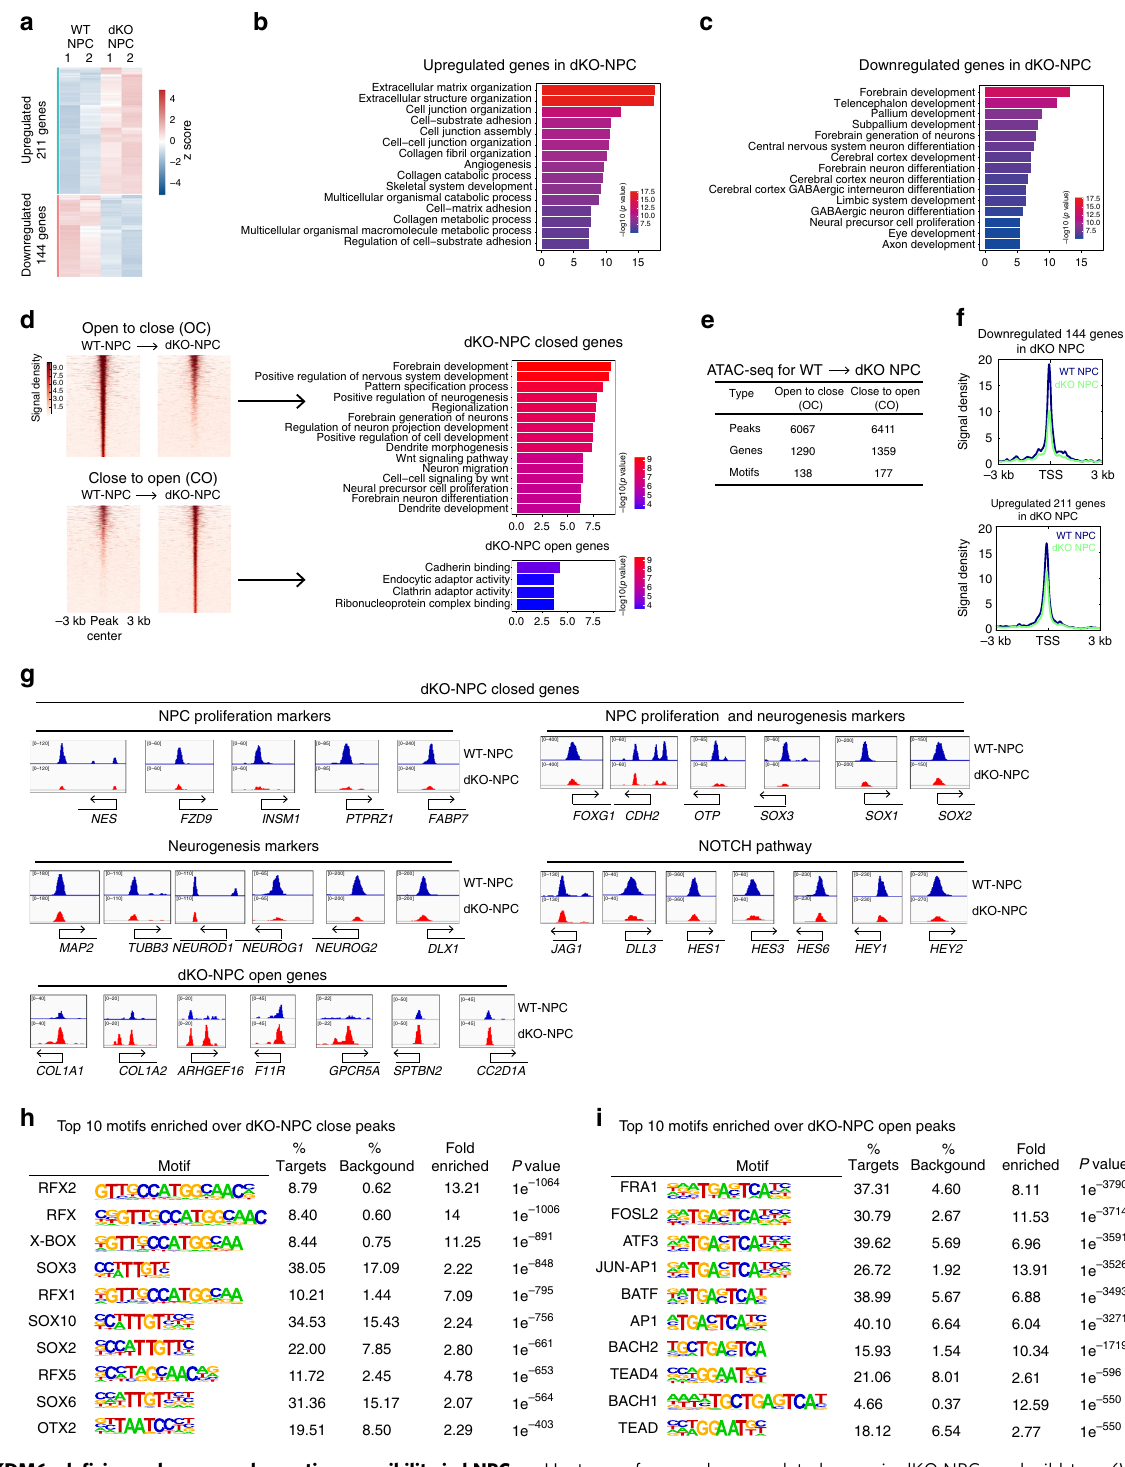
Fig. 4 KDM6s de fi ciency decreases chromatin accessibility in hNPCs. a Heatmap of up- or downregulated genes in dKO NPCs and wild-type (WT) NPCs at passage 2. b , c Top 15 GO terms most enriched in genes upregulated or downregulated in dKO NPCs. d Left panel, heatmap of ATAC-seq data indicating differentially accessible chromatin regions between WT NPCs and dKO NPCs. Right panel, top 15 GO terms most enriched in genes associated with decreased and increased chromatin accessibility in dKO NPCs. OC, open-to-closed, indicates regions with reduced chromatin accessibility in dKO NPCs. CO, closed-to-open, indicates regions with increased chromatin accessibility in dKO NPCs. e The numbers of OC or CO regions described in d . f ATAC-seq analysis of downregulated and upregulated genes in dKO NPCs and WT NPCs. g Genomic views of selected genes in WT NPCs or dKO NPCs from ATAC- seq data. These selected genes include those with functions of NPC proliferation, neuron development markers, NOTCH pathway genes and genes with increased chromatin accessibility in dKO NPCs. h , i Top 10 motifs most enriched over the OC or CO regions described in d